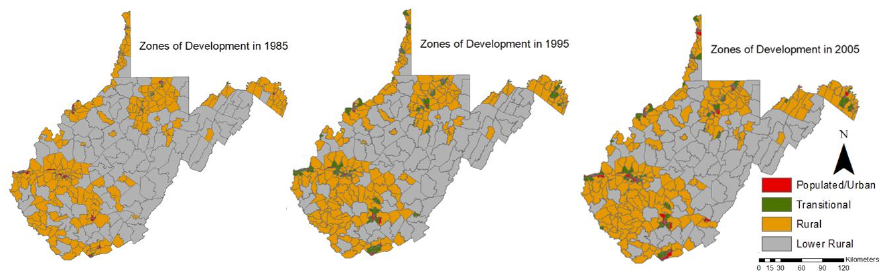
Figure 8. Zones of